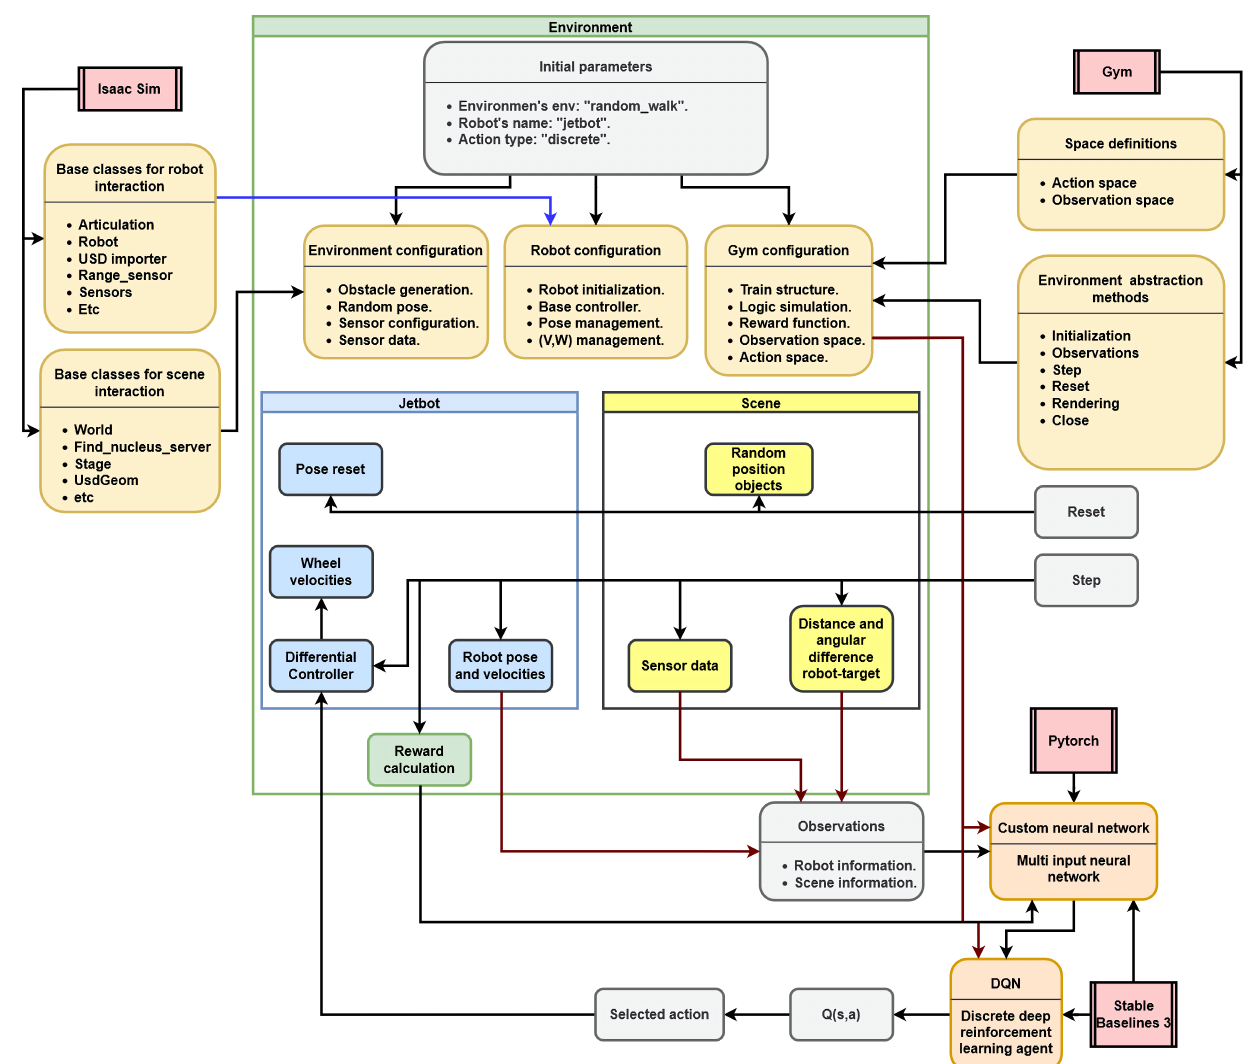
Figure 7. Isaac Sim’s study case structure, logic, and information